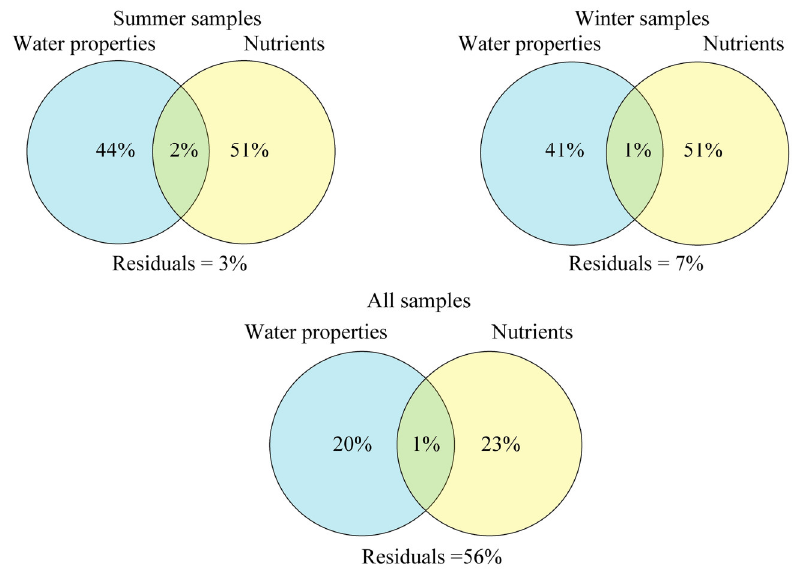
Figure 7. Variation partitioning analysis of the effects of water quality parameters (temperature, pH, salinity, Chl- a , DO, and COD) and nutrient levels (NO 2− -N, NO 3− -N, NH 4+ -N, DIN, TN, DIP, TOC, and TP) on the mycoplanktonic community composition in seawater from the Dafengjiang River estuary area.